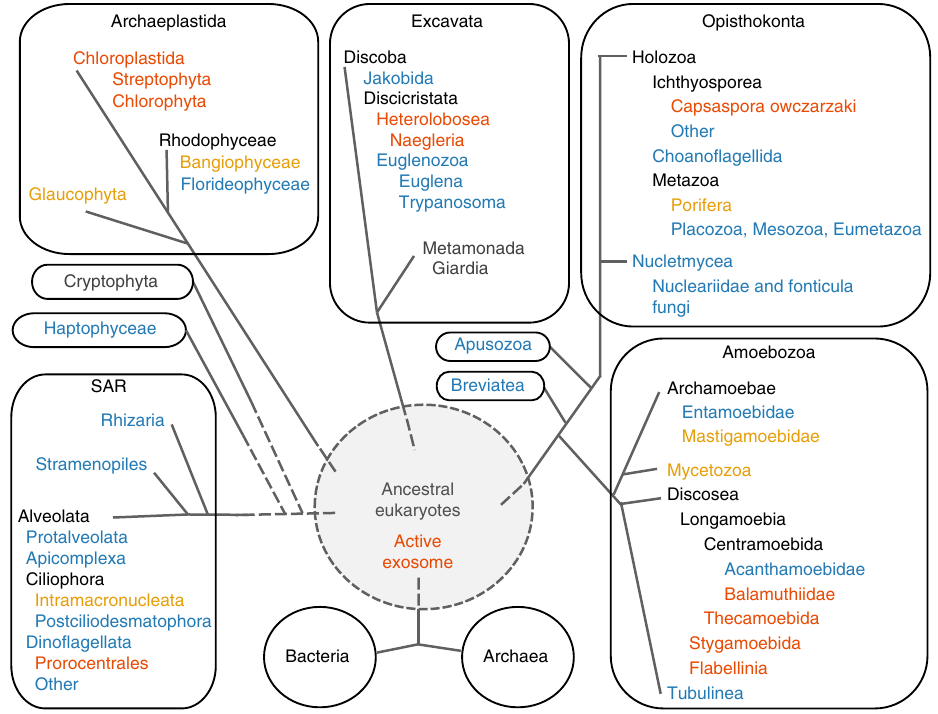
Fig. 8 Presence of potentially active Exo9 in eukaryotes. Sequences of RRP41 proteins from organisms of all eukaryotic phyla were analyzed for the conservation of amino acids that confer phosphorolytic activity to the Arabidopsis exosome. Red letters indicate that all species examined likely possess an active Exo9 complex based on the strict conservation of necessary amino acids in the respective RRP41 orthologues. Orange letters indicate a partial conservation of RRP41 amino acids, i.e. the substitution of critical residues by amino acids with similar chemical properties. Blue letters indicate species whose RRP41 proteins are predicted to be catalytically inactive. Bacteria or Archaea were not included in this analysis as they do not posses the nine- subunit eukaryotic exosome complex per se. However, many of both Archaea and Bacteria possess phosphorolytic active enzymes that share structural similarity with eukaryotic